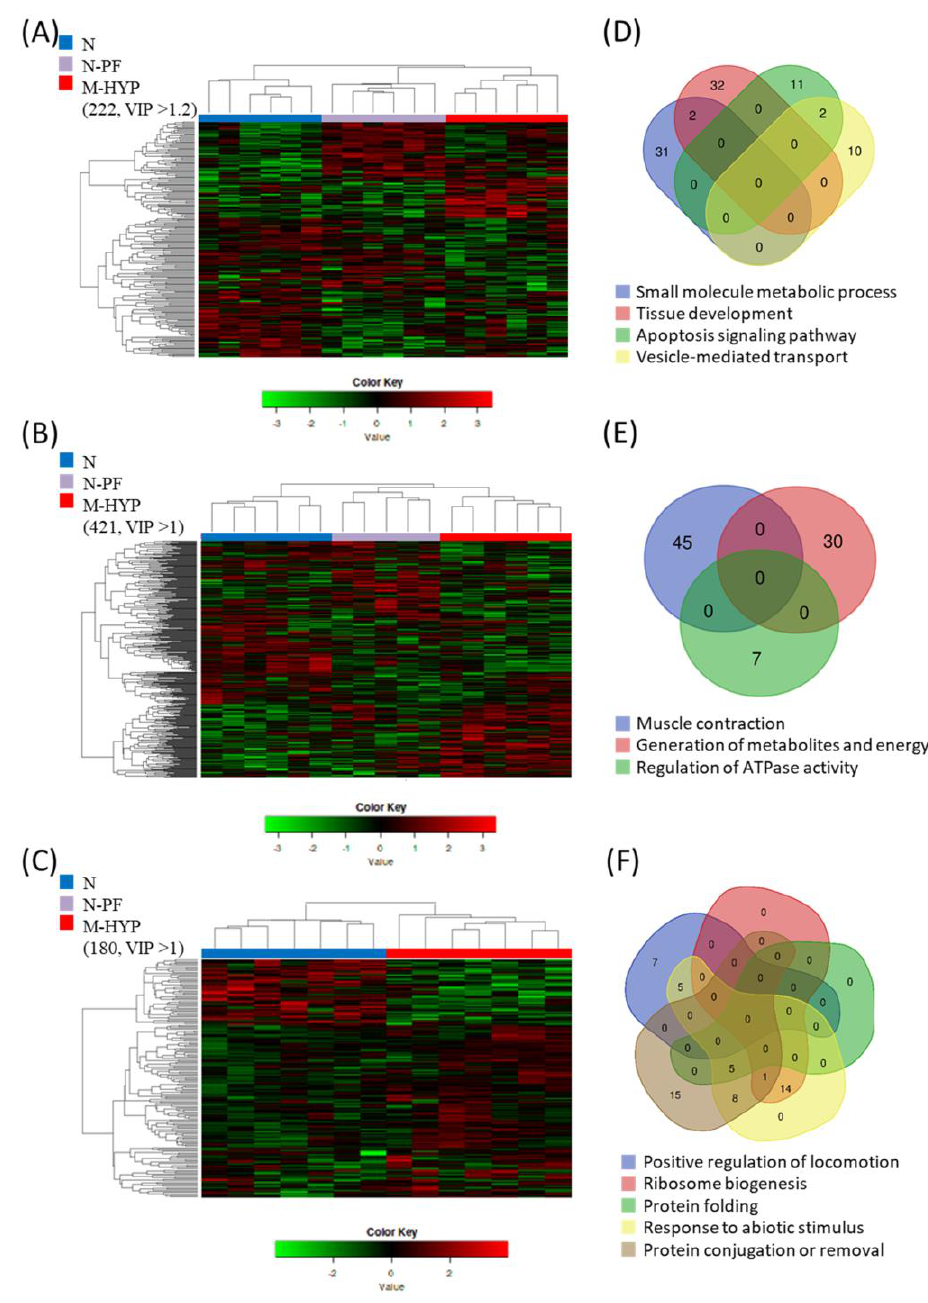
Figure 5. Clustering and gene enrichment analysis. Heatmap showing the abundance distribution (z-score) of the DE genes identified to be driving the separation between groups at the end of the mild-hypoxia conditioning period (t 45H ) before ( A ) and after exhaustion exercise ( B ), and at the end of the normoxia recovery period (t +21N ) after exhaustion exercise ( C ). Venn diagrams show the level of overlapping of enriched GO-BP categories at the end of the mild-hypoxia conditioning period before ( D ) and after exhaustion exercise ( E ), and at the end of the normoxia recovery period after exhaustion exercise ( F ).